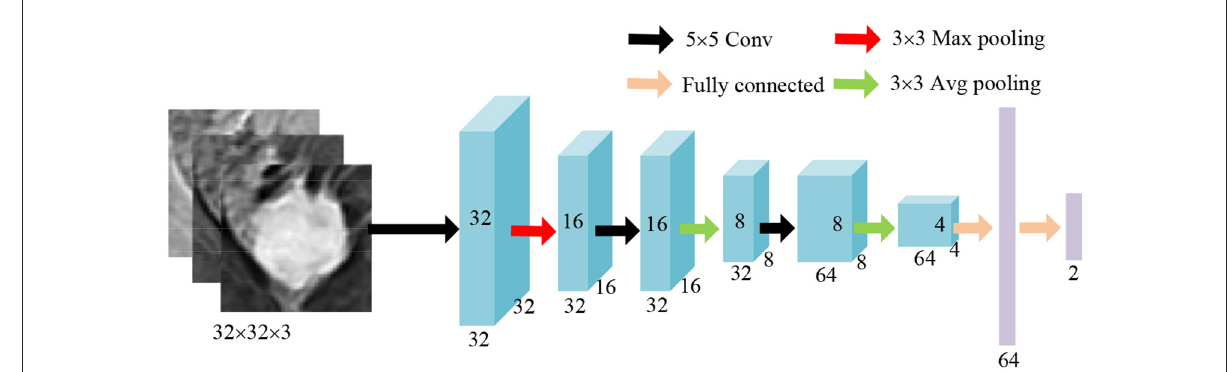
FIGURE6 An illustration of the classification network.